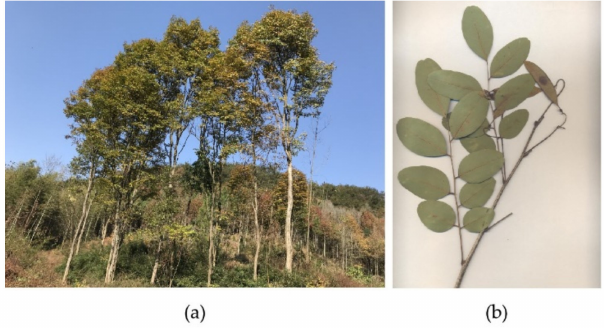
Figure 1. Photographs of the studied species D. hupeana depicting its ( a ) habitat in China and ( b ) leaves and